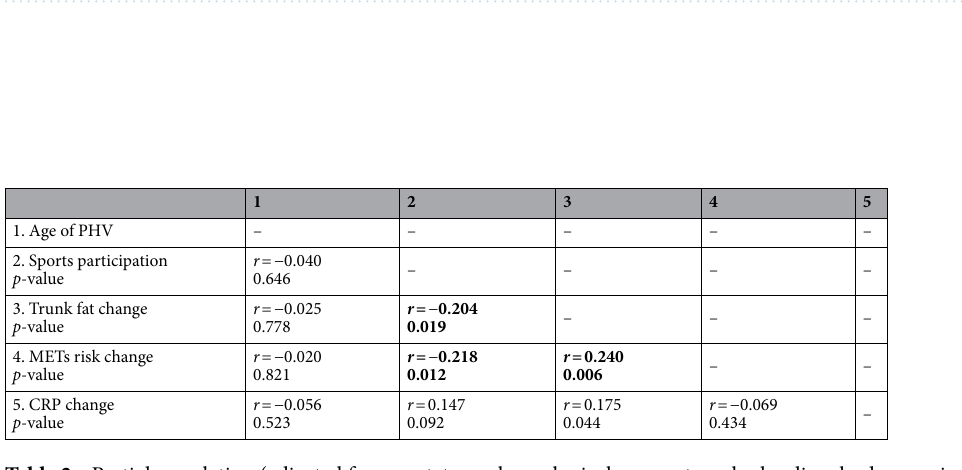
Table 2. Partial correlation (adjusted for sex, stature, chronological age, maternal schooling, body mass index, sugary foods consumption and transport physical activity) describing the relationship between exposure, mediators, and outcomes. Values are presented using correlation coefficients. PHV, peak of height velocity. METs, metabolic syndrome. CRP, C-reactive protein. Bold values represent p <